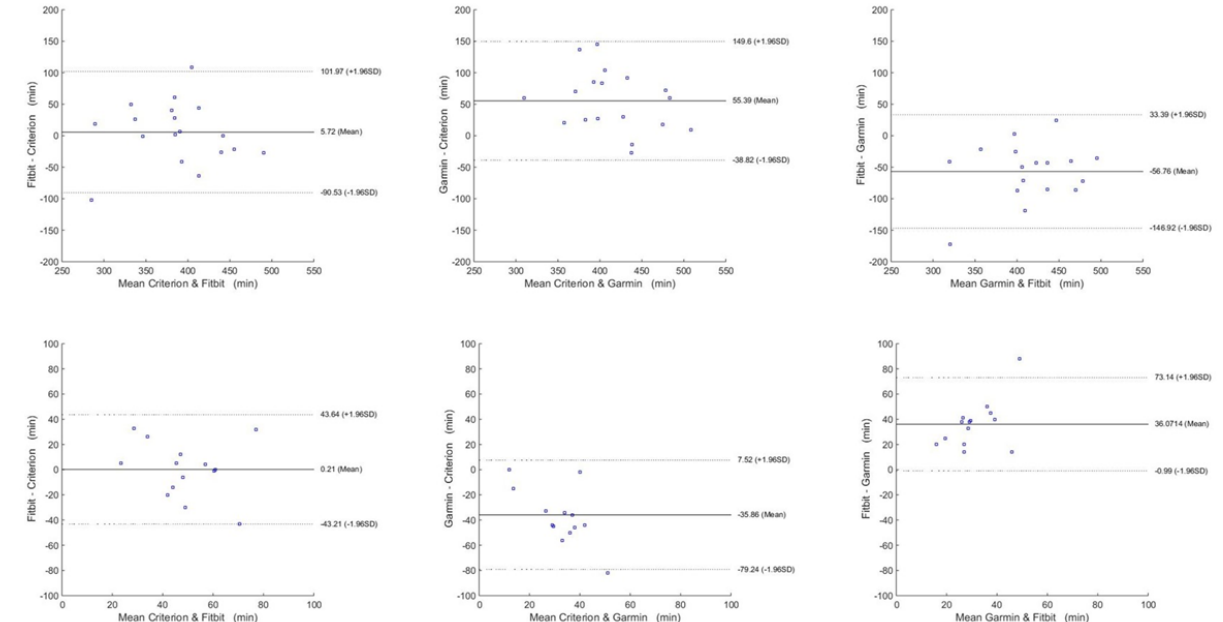
Figure 6. Bland-Altman plots for sleep parameters. Top row: total sleep time; bottom row: wake after sleep